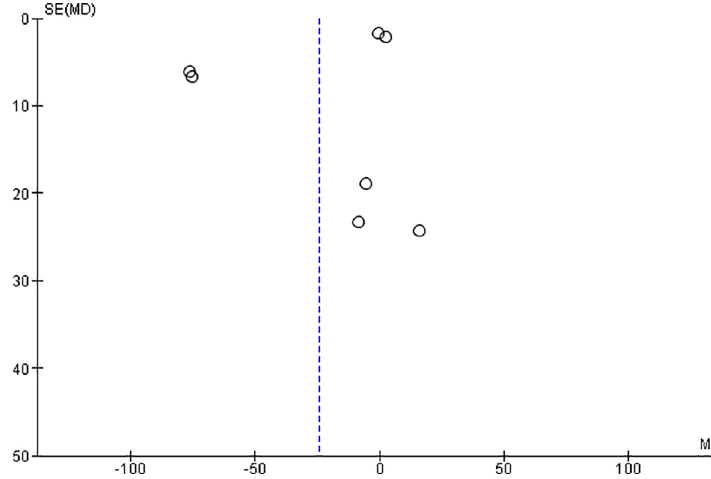
Figure 6. Funnel plot for Funnel plot: